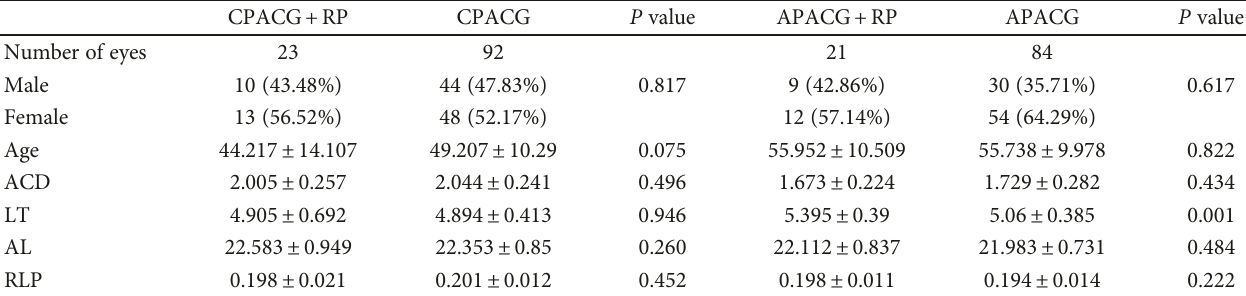
Table 1: Ocular biometry in the PACG associated with RP and PACG groups after propensity score matching.